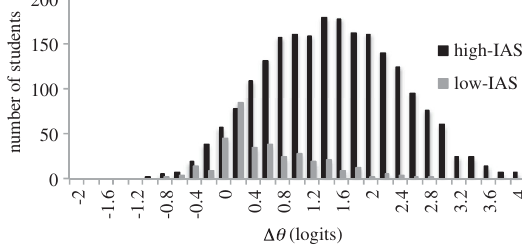
FIG. 8. The distribution of IRT-estimated gains ( Δ θ ) for the 2178 students in high-IAS classes and the 363 students in low- IAS classes.